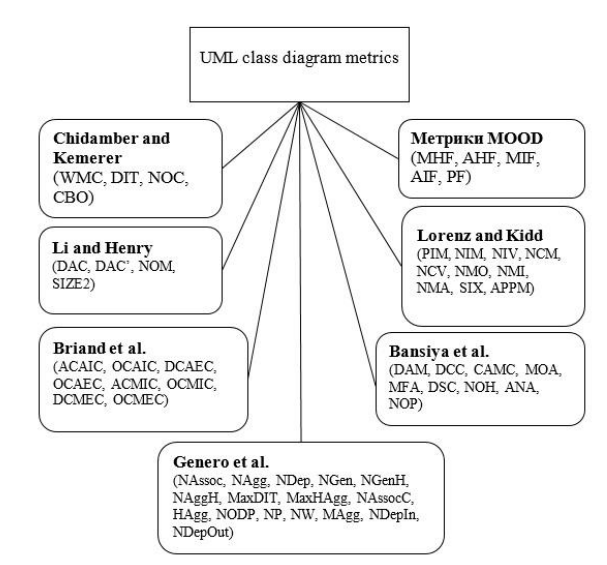
Fig. 1. UML class diagram